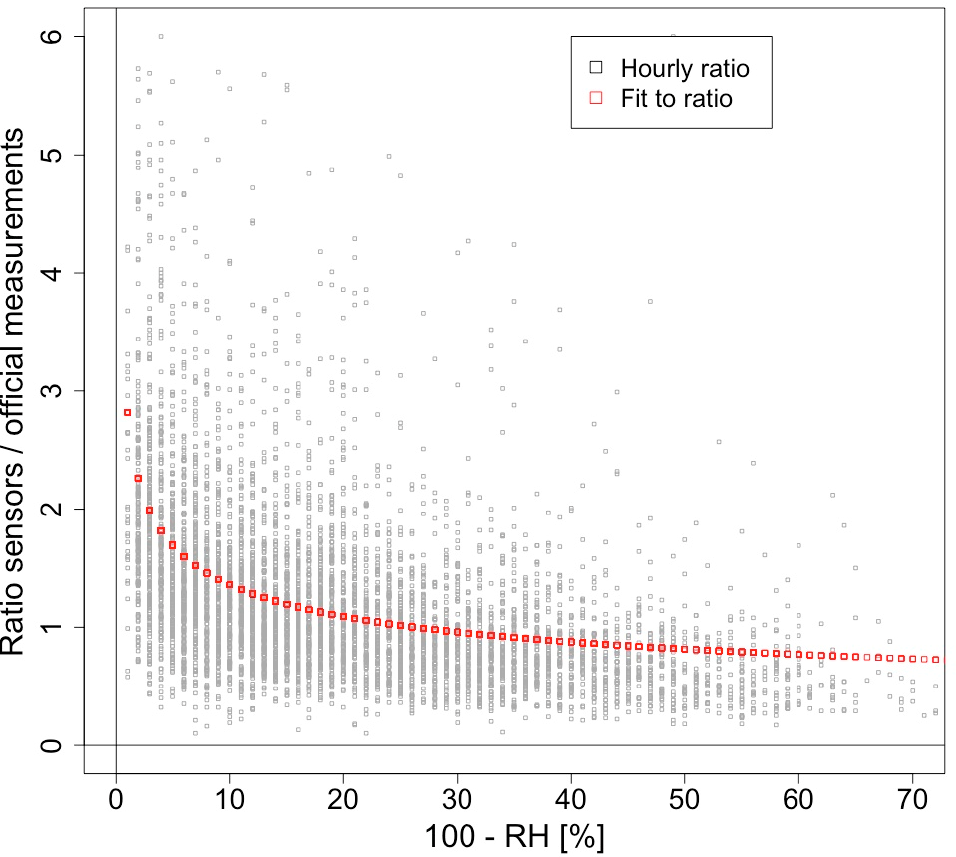
Figure 4. Ratios between the official hourly PM 2.5 measurements at Amsterdam Vondelpark and the average of 20 (Nova SDS011) sensors in the center of Amsterdam as a function of (100-RH), where RH is the relative humidity (in %).